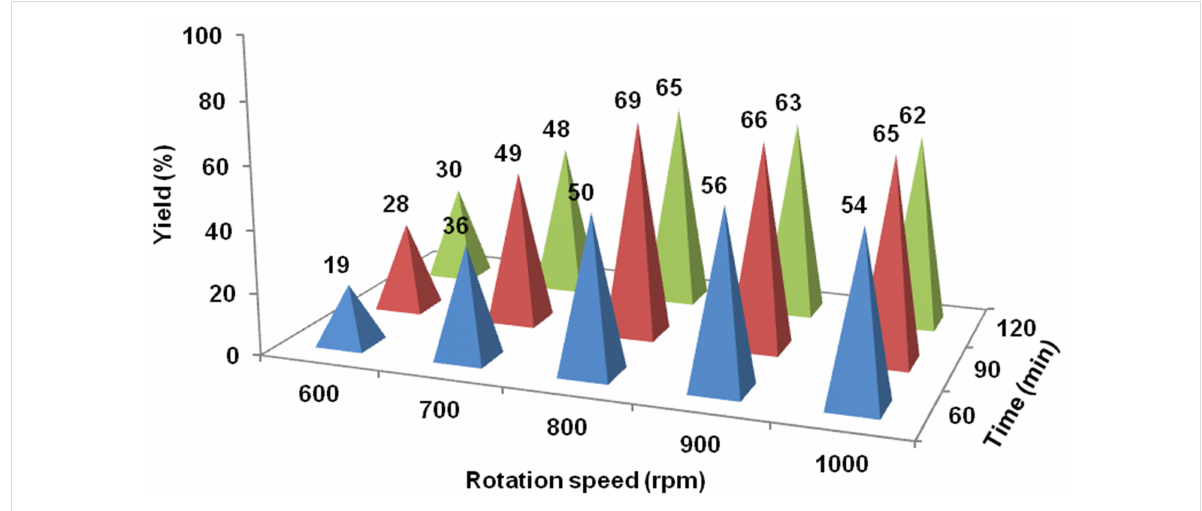
Figure 2: Influence of milling time and rotation speed on the Heck reaction: 1a (1.5 mmol), 2a (2.25 mmol), Pd(OAc) 2 (5 mol %), PPh 3 (10 mol %), TEA (1.8 mmol), TBAB (5 mol %), and NaBr (10.0 g) were placed in 80 mL stainless steel vessel with stainless-steel balls ( d MB = 6 mm, Ф MB = 0.245).